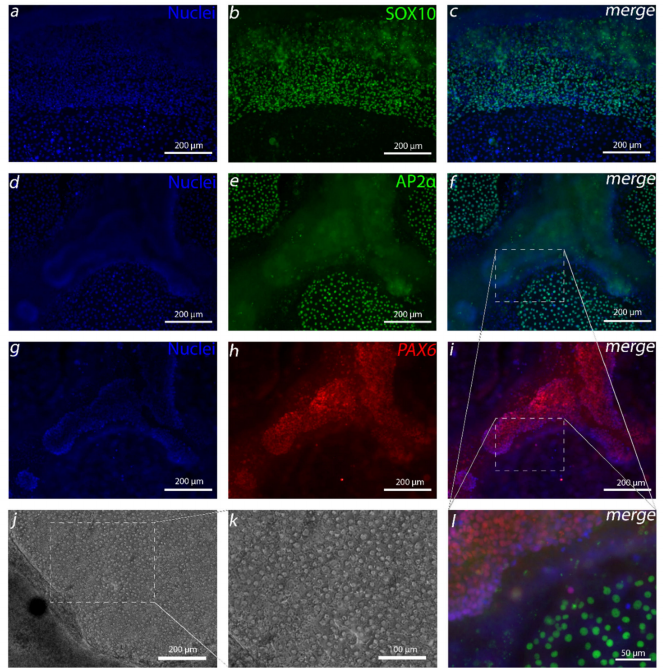
Figure 2. NCC induction resulted in three distinct cell populations. After 14 days of NCC induc- tion, three distinct cell populations were discovered: ( a – c ) cells expressing SOX10, ( d – f ) activating enhancer binding protein 2 alpha (AP2 α ) and ( g – i ) paired box protein 6 (PAX6). ( l ) AP2 α and PAX6 images are merged and enlarged 3 × to highlight distinct populations between PAX6 and AP2 α -positive cells. ( j , k ) Phase contrast light microscope images show the polygonal morphology of the monolayered AP2 α -positive cells. Data conducted with the Regea08/017 human embryonic stem